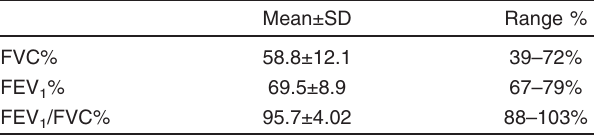
Table 3 Ventilatory function values among the studied group